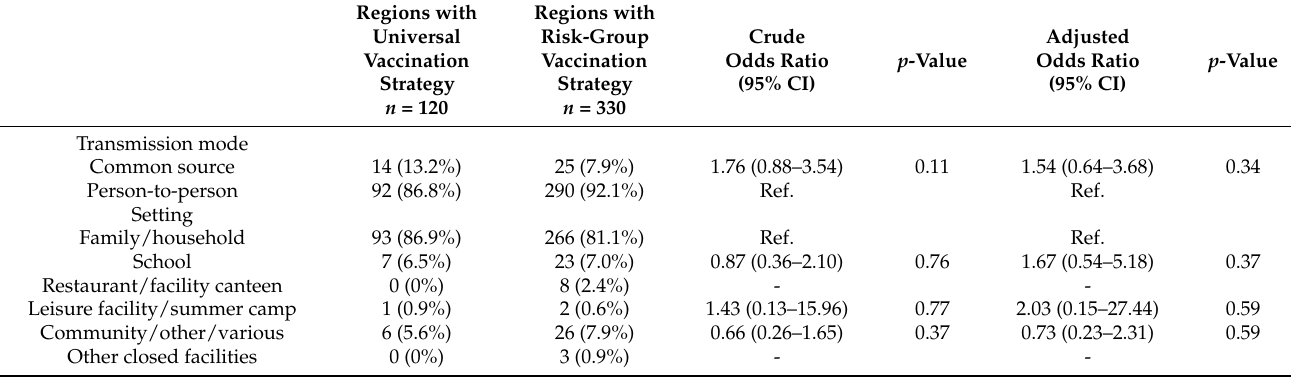
Table 2. Characteristics of hepatitis A outbreaks in regions with different vaccination strategies. Spain, 2010–2018.